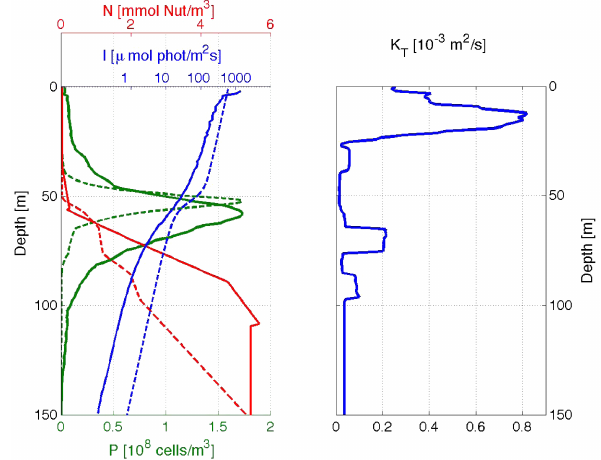
Figure 5. Measurements (solid lines) and model results (dashed lines) at the southern station. Left panel: phytoplankton concentra- tion (green), nutrient concentration (red) and light intensity (blue). The LSM is based on the depth and the value of the DCM. Right panel: vertical mixing coefficient K T